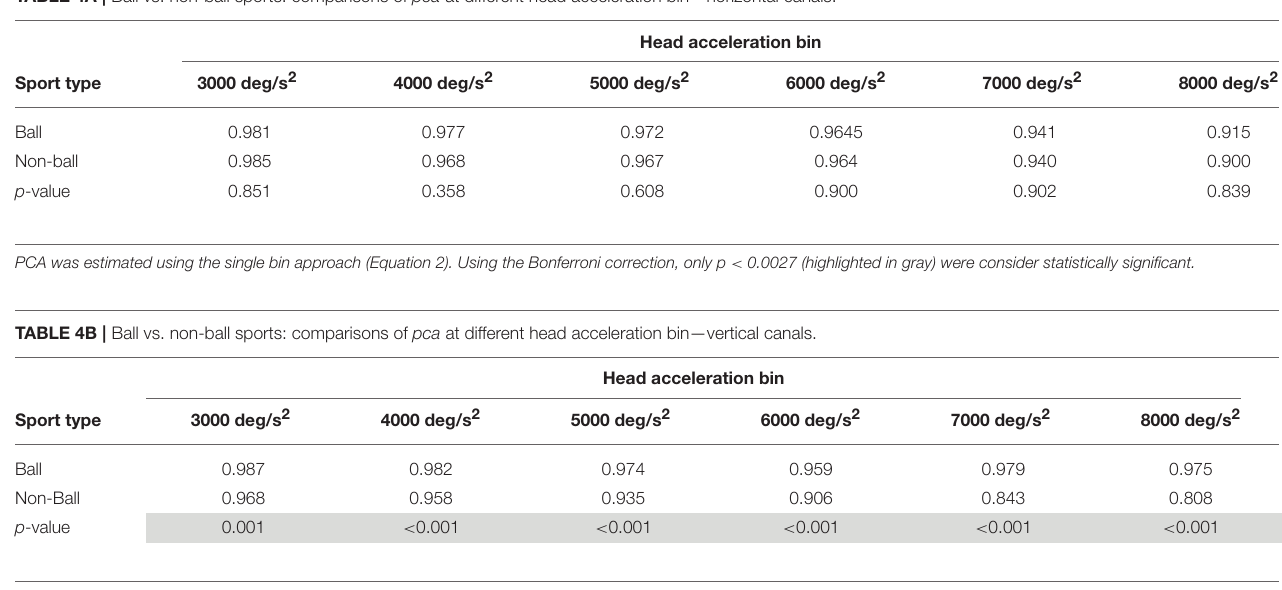
TABLE 4A | Ball vs. non-ball sports: comparisons of pca at different head acceleration bin—horizontal canals.